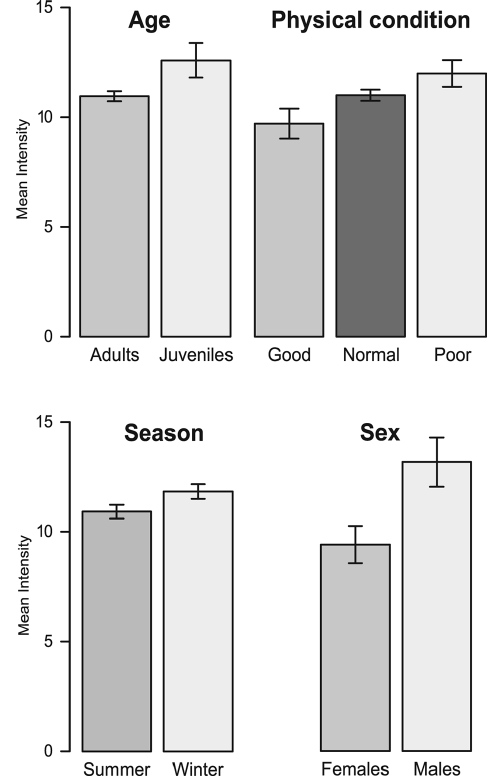
Figure 2. Mean intensities by age, physical condition, season and sex in Zaedyus pichiy from Mendoza,